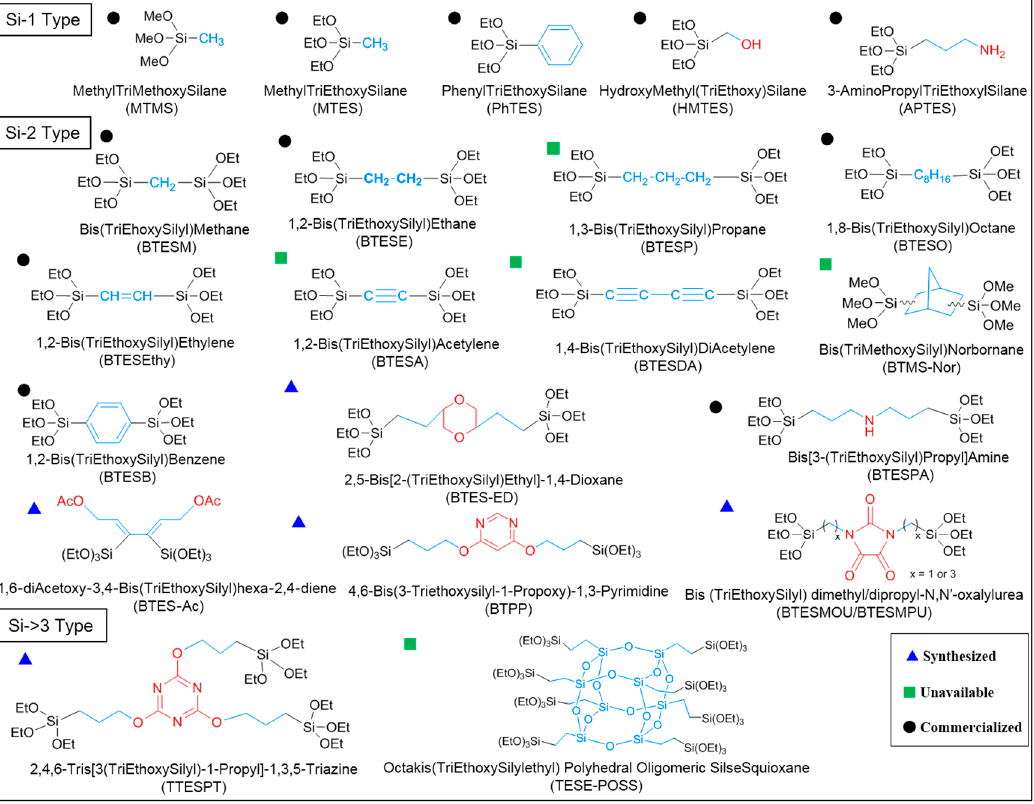
Figure 1. Most of the organoalkoxysilane materials along with their chemical structures. (Et: ethyl; Me: methyl; Letters in brackets are their abbreviation name.).